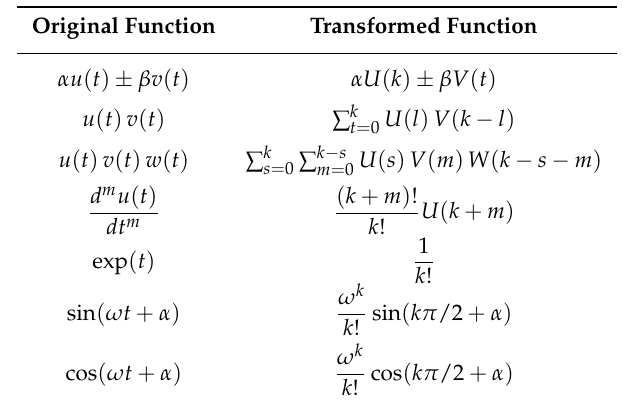
Table 1. The fundamental operations of the differential transform method